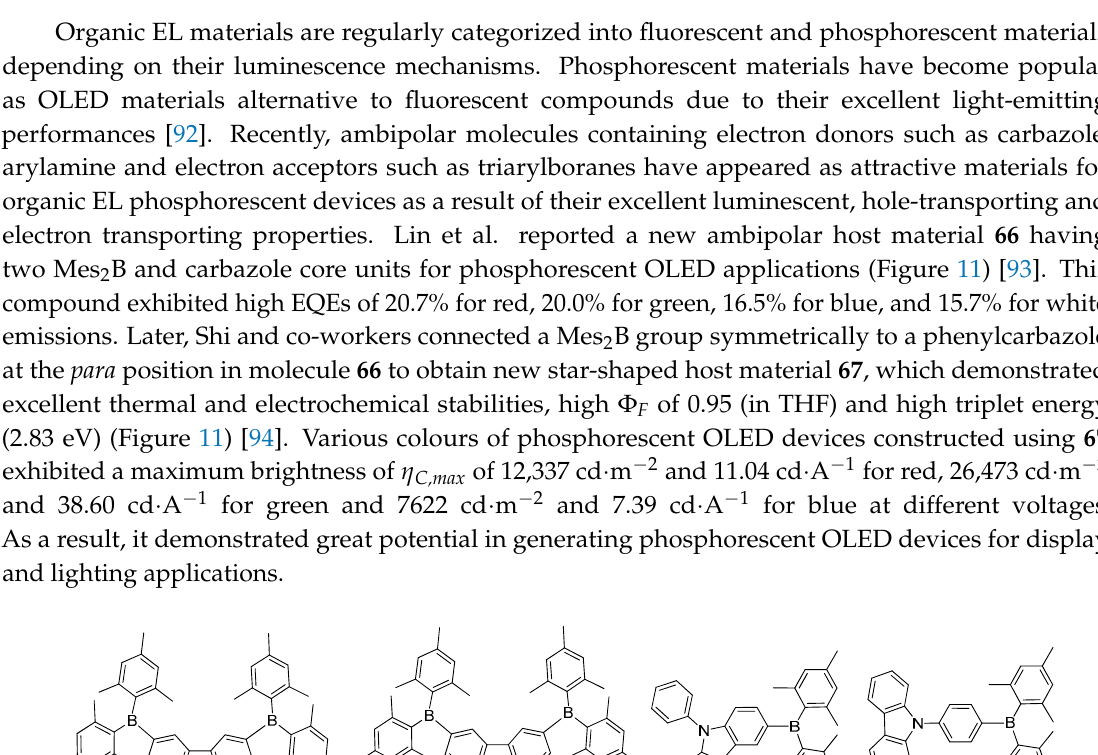
Figure 11. Triarylborane based phosphorescent materials 66 – 69 .